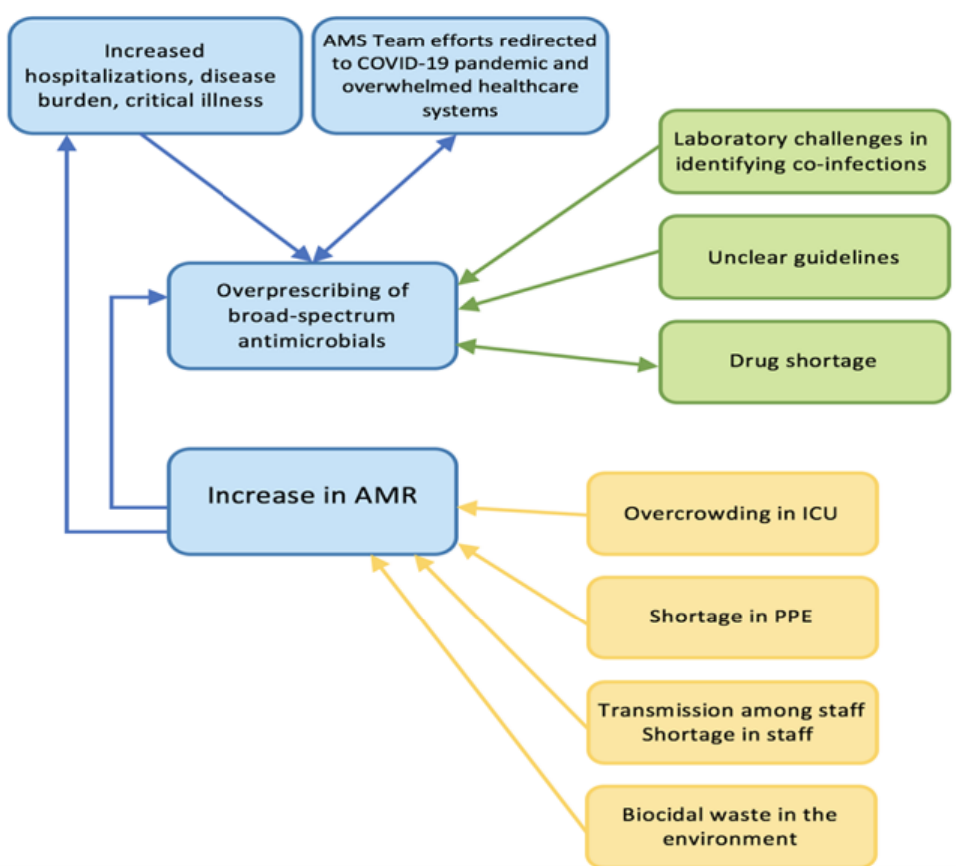
Figure 2. Factors contributing to the increase in AMR during the COVID-19 pandemic. AMR, antimicrobial-resistant; AMS, antimicrobial stewardship; ICU, intensive care unit; PPE, personal protective equipment.